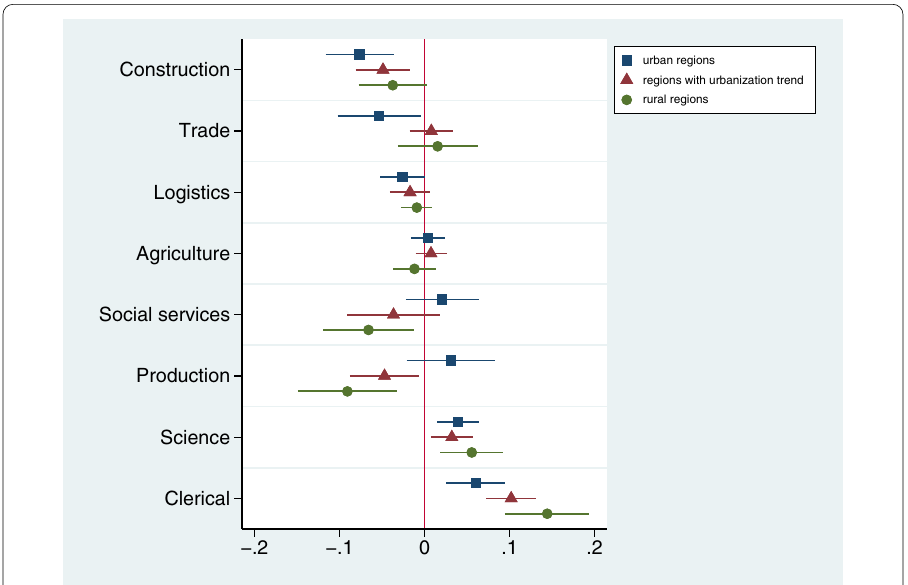
Fig. 9 Interaction of secondary school degree with type of region. Data source: NEPS, SC4, estimation see Table